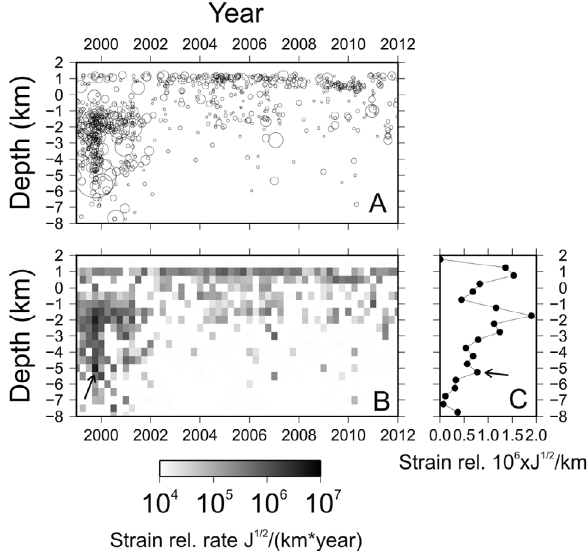
Figure 9. Gutenberg-Richter relationship for located earthquakes. Triangles are experimental data for events located a.s.l. while circles are for the deeper events. The theoretical relationship for triangles = 0.9. For the circles the has parameters b = 1.01 and a = 3.6 with M c parameters are b = 1.26, a = 4.55 and M = 1.7. c